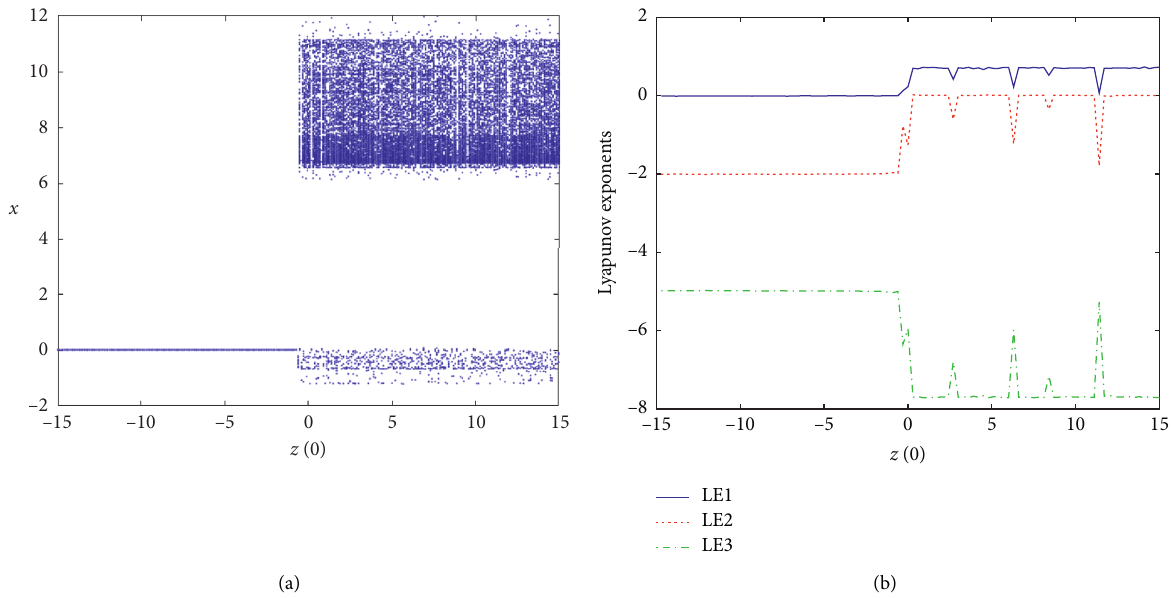
� [1, 2, z 0 , y 0 , z 0 ] 0 ]. (a) Bifurcation